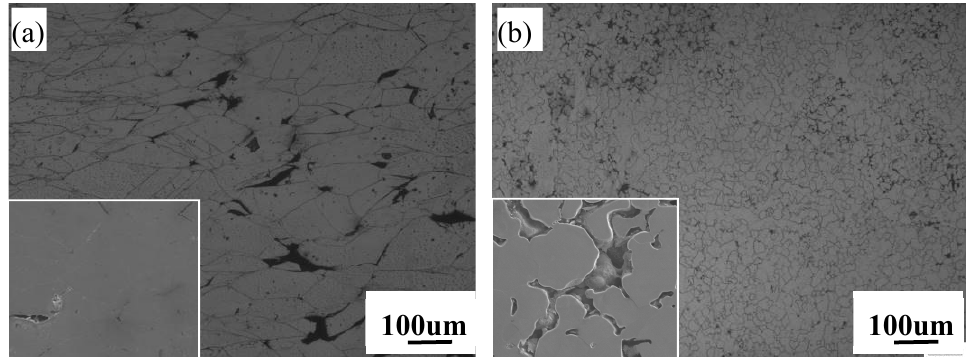
Figure 15. The cracks in the depressed samples of 2W; ( a ) 950 °C with a strain rate of 1 s − 1 ( b ) 1200 °C with a strain rate of 1 s − 1.